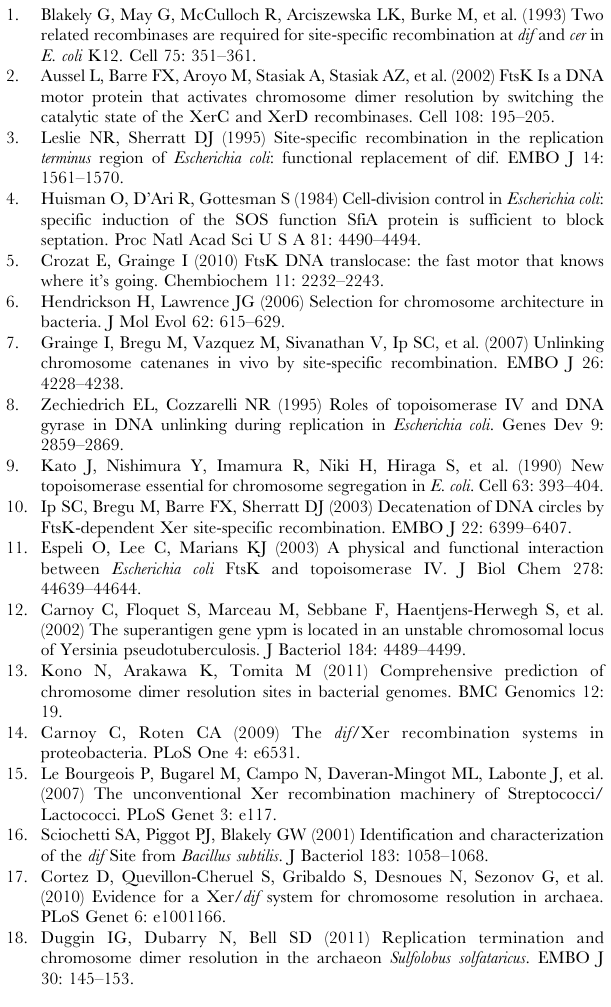
Table S1 Plasmids and bacterial strains used in this study. Table S2 Oligonucleotide primers used in this study. Table S3 Nucleotide frequency (%) and consensus difH sequences from 24 epsilon-proteobacterial species chro-